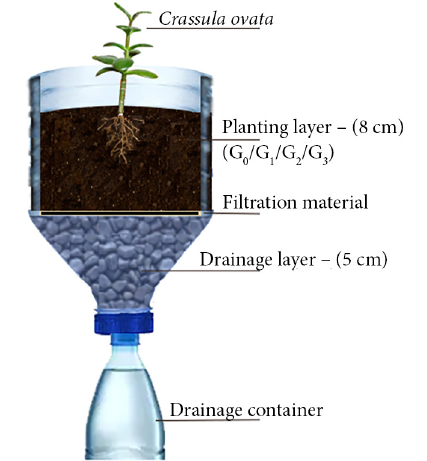
Figure 2. Cross-section of the sample pot used in